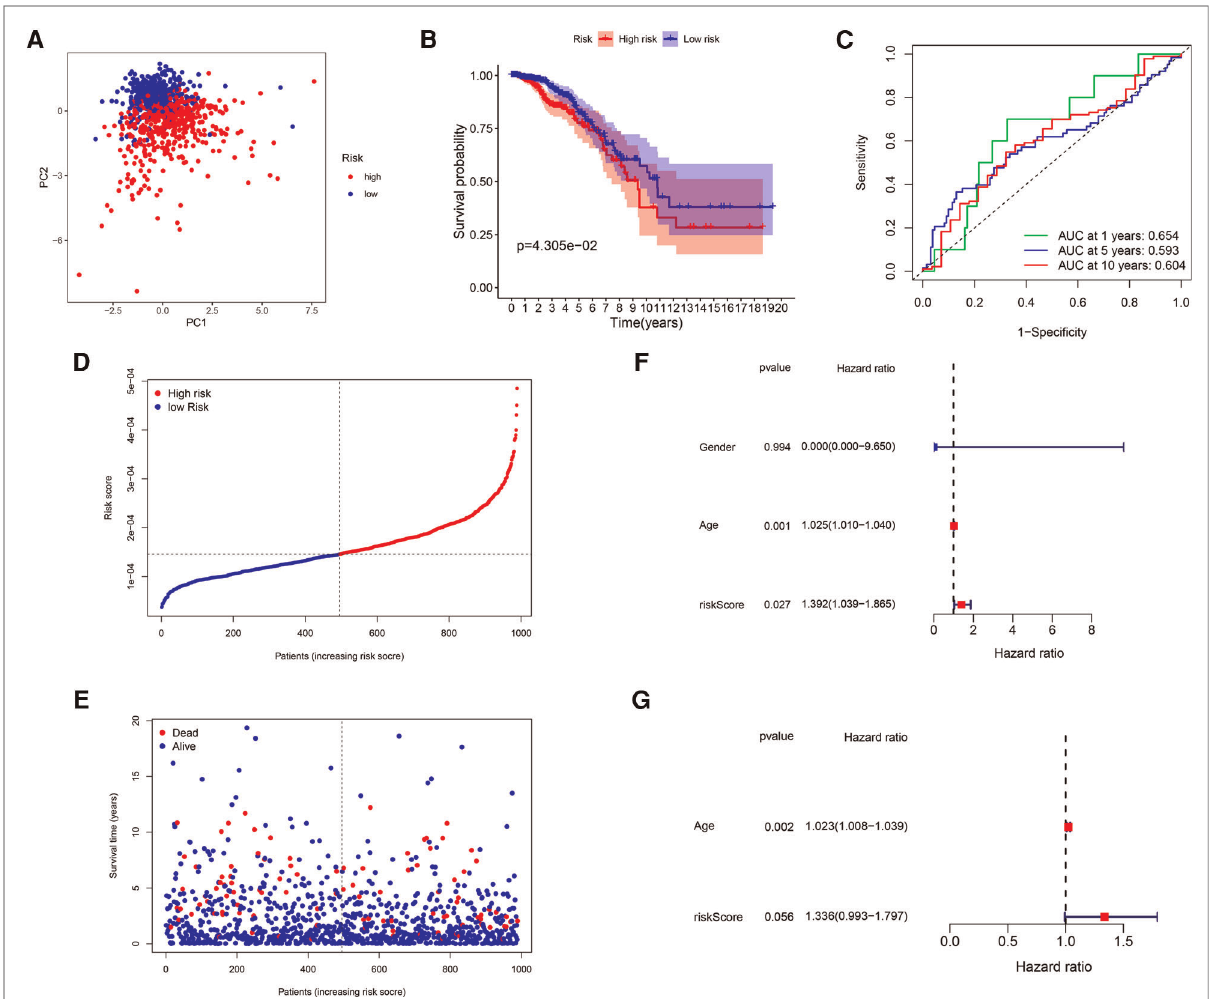
FIGURE 4 Validation of the GRG signature in ICGC cohort. ( A ) PCA based on risk score of GRGs. ( B ) Kaplan – Meier survival curves between high-risk and low- risk groups. ( C ) The ROC curves of 1-, 5- and 10-years OS. ( D,E ) Survival status of each patient. ( F,G ) Univariate and multivariate Cox regression analyses.